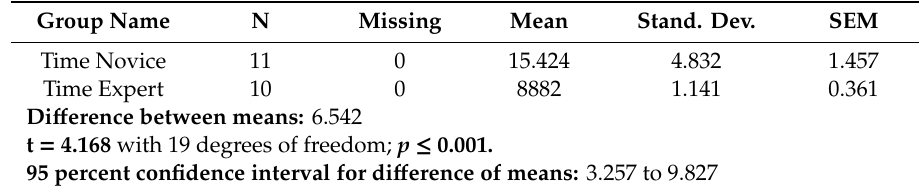
Table 5. Paired comparison statistics (Student’s t) for the task times of the expert and the novice from ten and eleven successive task sessions,